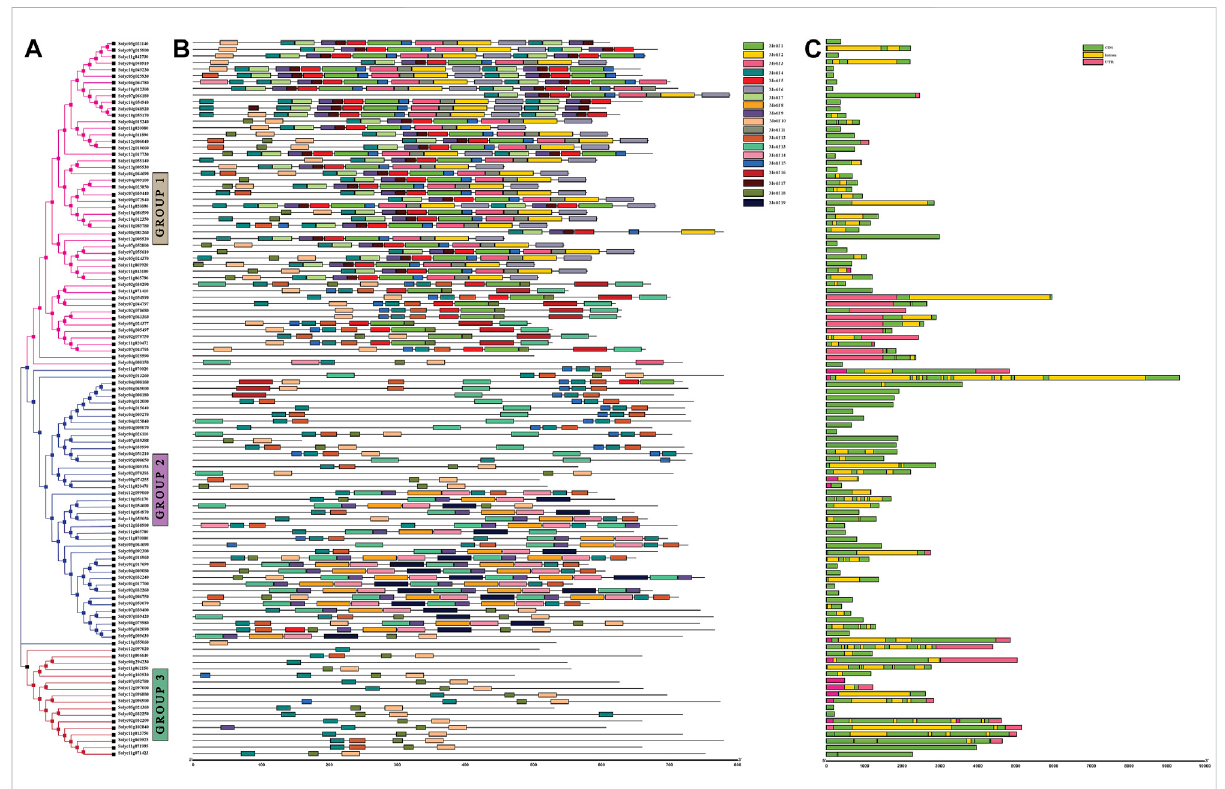
FIGURE 1 Rectangular tree image with motifs and gene structure analyses from TBtools. (A) Phylogenetic tree of NLR genes sharing partial domain (NB- coding genes) constructed in MEGAX using the maximum likelihood (ML) method with 1000 bootstrap replications. (B) Conserved motif composition/patterns represented in different colors generated using the MEME tool. (C) Gene structure analysis by GSDS.2.0. Green: CDS, pink: UTRs, yellow: